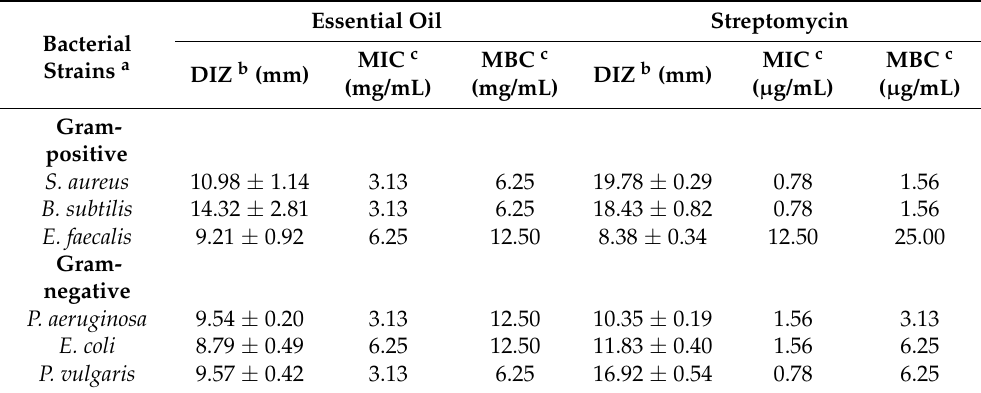
Table 3. Antibacterial activity of A. galanga flower essential